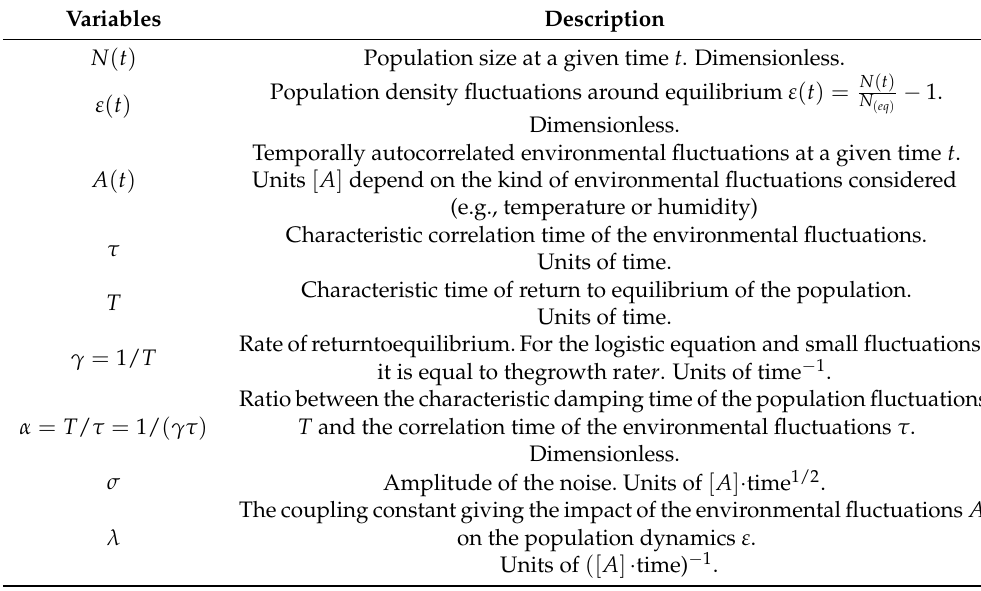
Table 1. Variables used with its description and units.